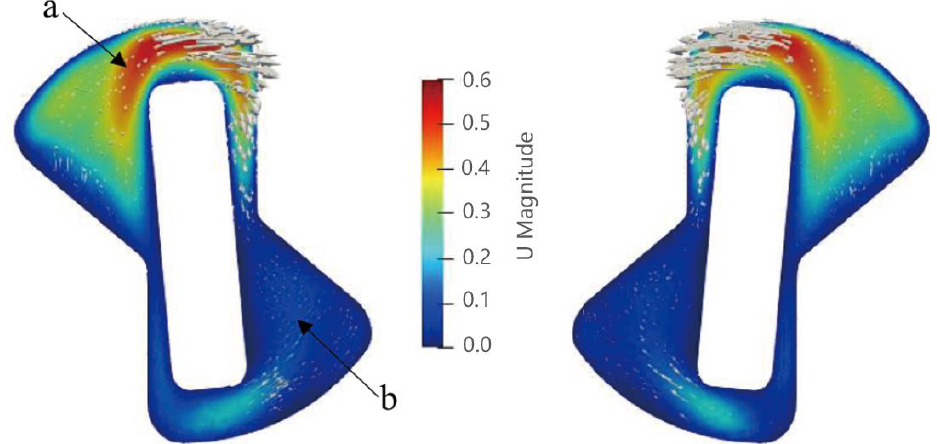
Figure 15. Peak velocity phase, velocity contours, and vector inside the hinge region in a plane with a distance of 0.15 mm from the hinged floor (a) adjacent corner; (b) side angle (Newtonian model). Complex flow patterns and lower flow velocities at the hinge can increase residence time, blood cell aggregation, and cumulative damage, resulting in thrombosis and impaired hinge function.